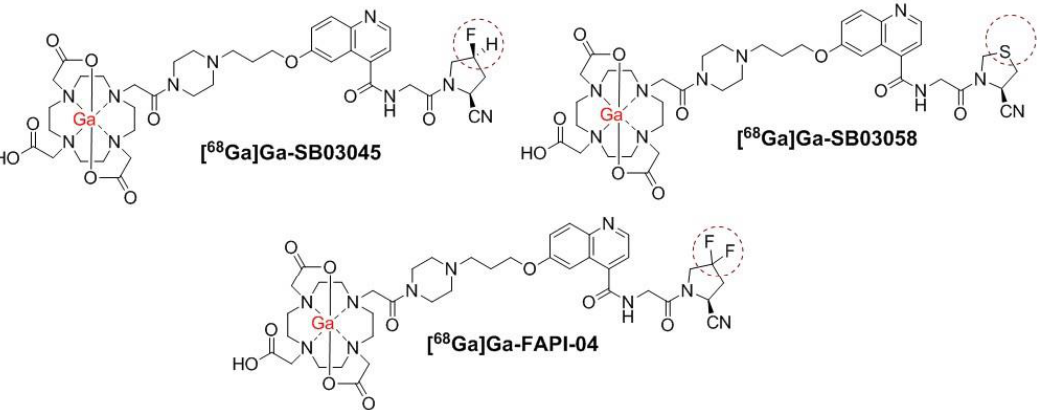
Figure 1. Chemical structures of 68 Ga-labeled SB03045, SB03058 and FAPI-04. The radiolabels are in red. The differences between these three chemical structures are indicated in the brown dashed circles.